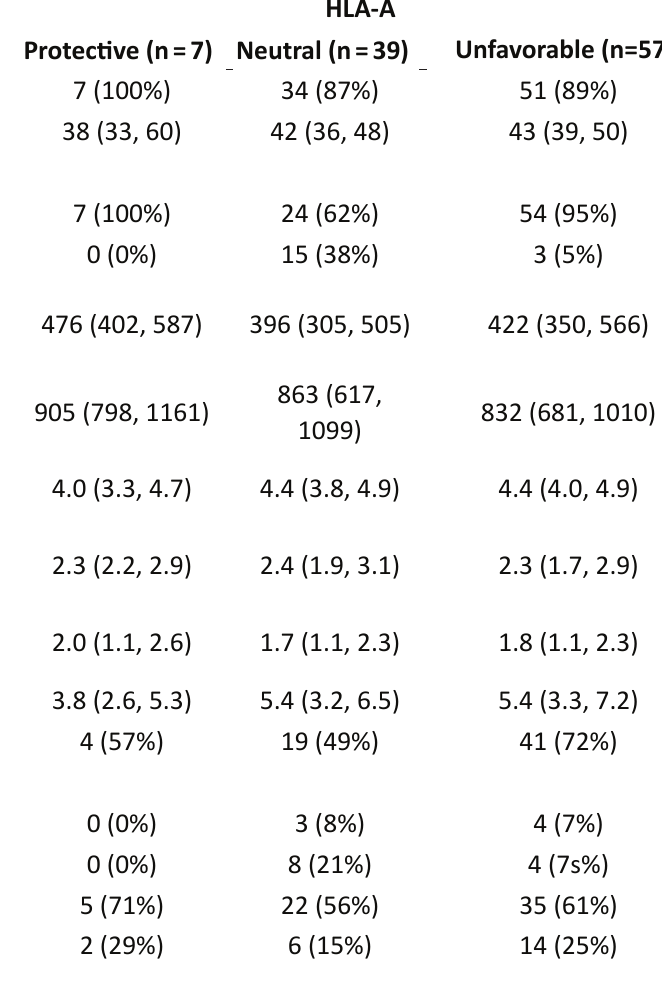
Supplementary Table 1. Baseline characteristics for HLA-A groups